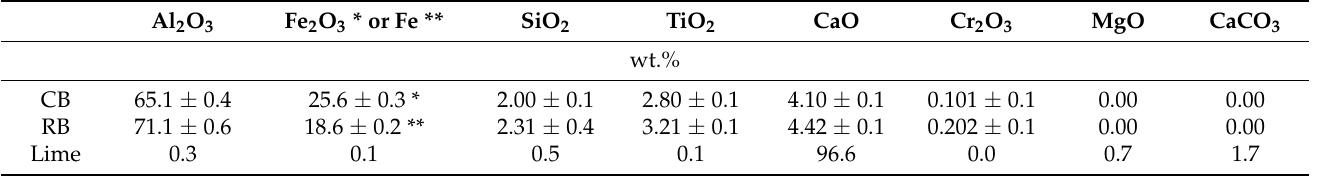
Figure 6. XRD analysis of raw, calcined, and H 2 -reduced bauxite. Table 2. Chemical composition (wt.%) of the raw materials as measured by XRF with the calculated st. deviation and Lime as